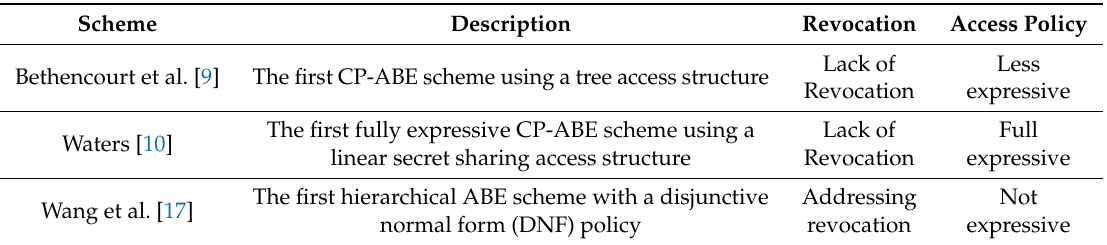
Table 1. Summary of the proposed ABE